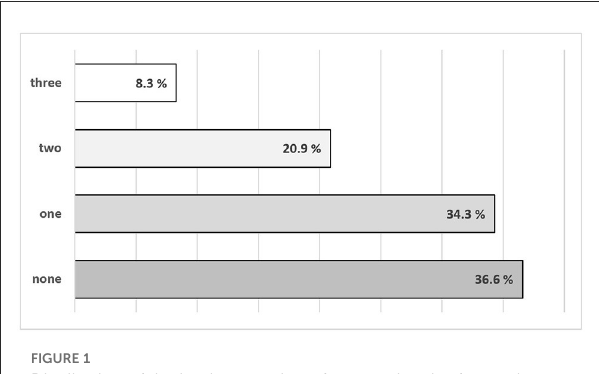
FIGURE1 Distribution of the implementation of occupational safety and health measures in German schools during the SARS-CoV-2 pandemic in March 2021.